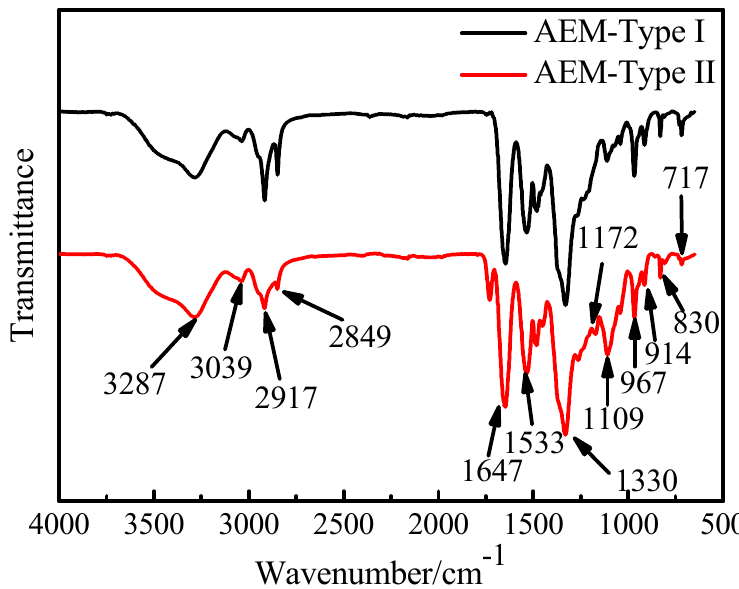
Figure 4. FT-IR spectra of two anion exchange membranes: AEM-Type I and AEM-Type II.